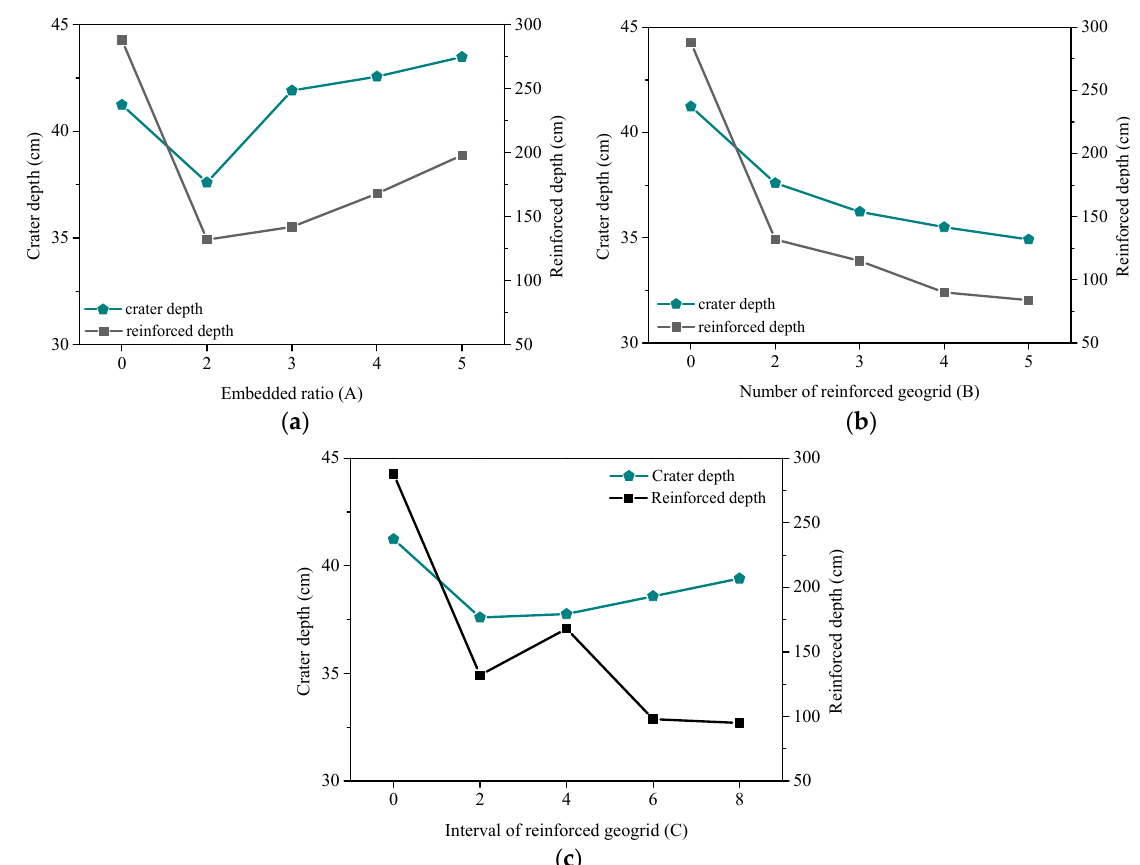
Figure 7. Crater depth and reinforced depth under different reinforced factors: ( a ) embedded ratio; ( b ) number of reinforced layers; ( c ) interval of reinforced layers.